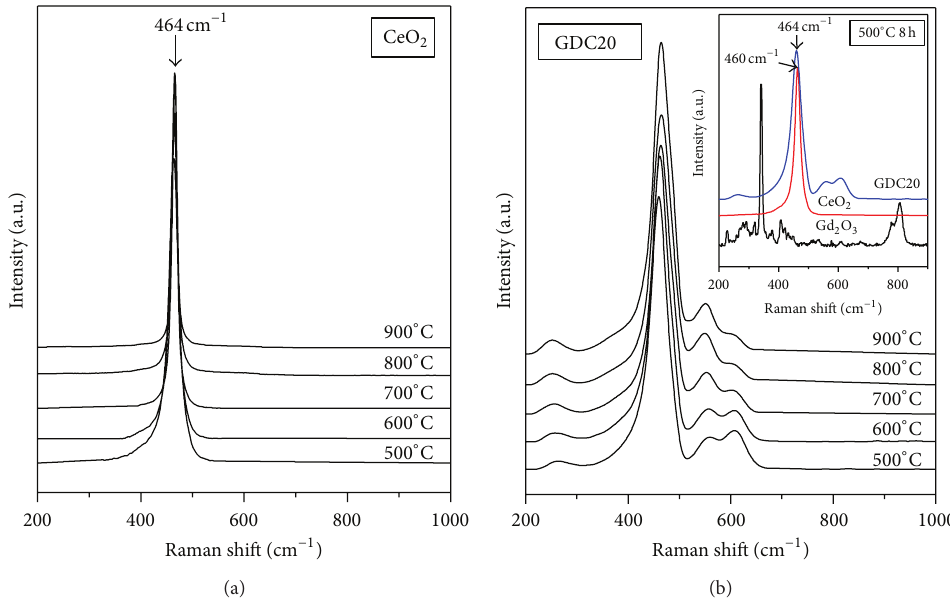
Figure 9: Raman spectra of (a) CeO 2 and (b) GDC20 nanofibers calcined at 500–900 ∘ C for 8h in air.